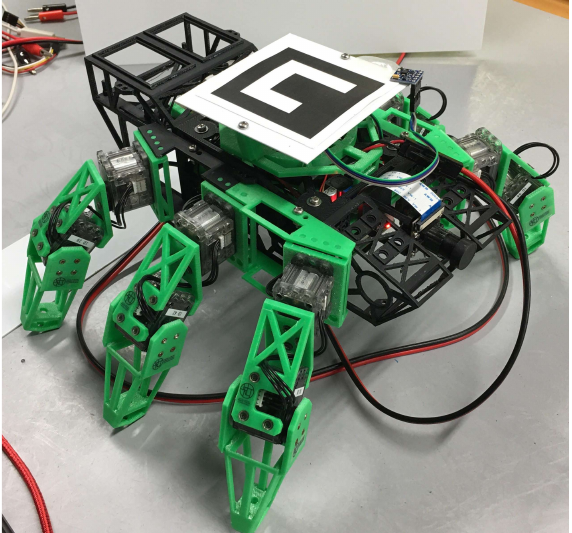
Figure 5. Different robot embodiment. The system configuration for elements such as servo motors and touch sensors is the same as in Robot 1. Only the number of joints and rotation angles of the joints are different from Robot